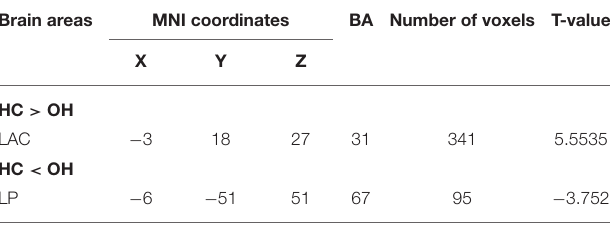
TABLE 3 | Compared with HC group, the fALFF values in OH